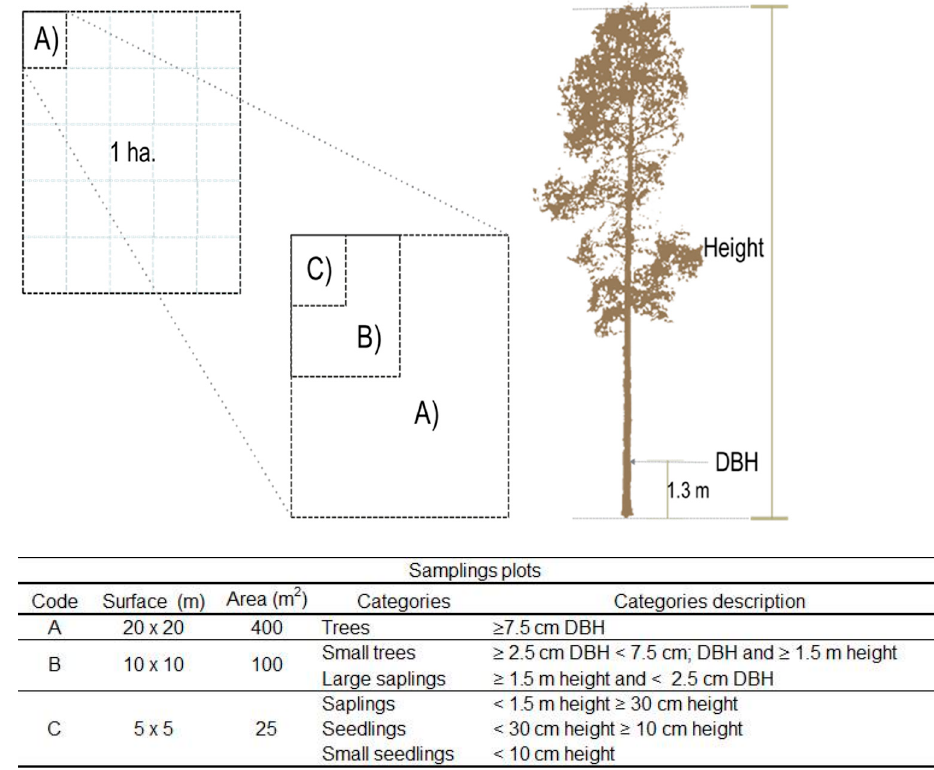
Figure 2. Sampling design with a 1 ha plot with 25 subplots sampled during each harvest year. Tree measurements for height and DBH. Sampling plots were distributed based on tree size clas- ses.